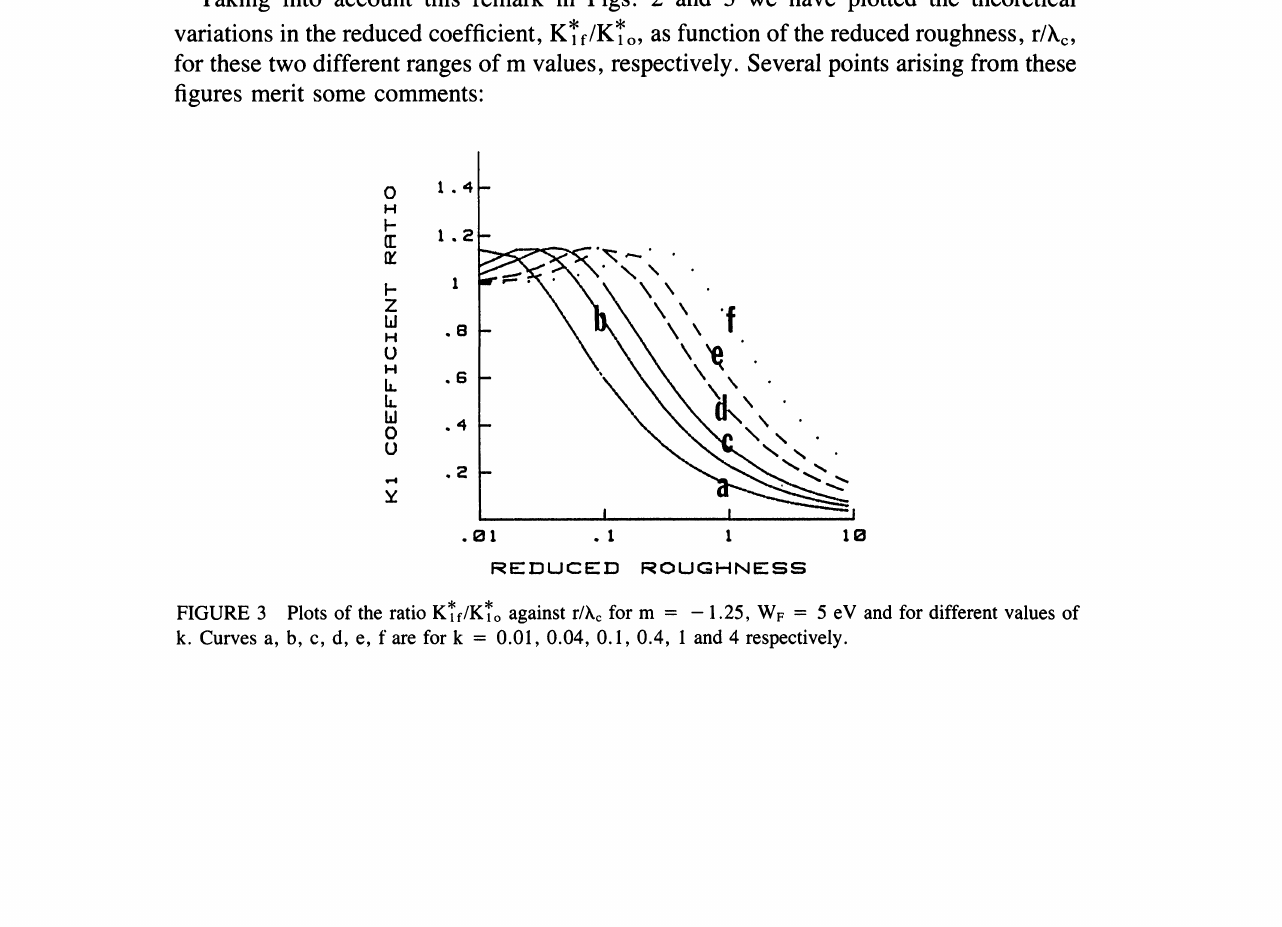
Curves a, b, c, d, e are for k 0.01, 0.04, 0.1, 0.4 and respectively.